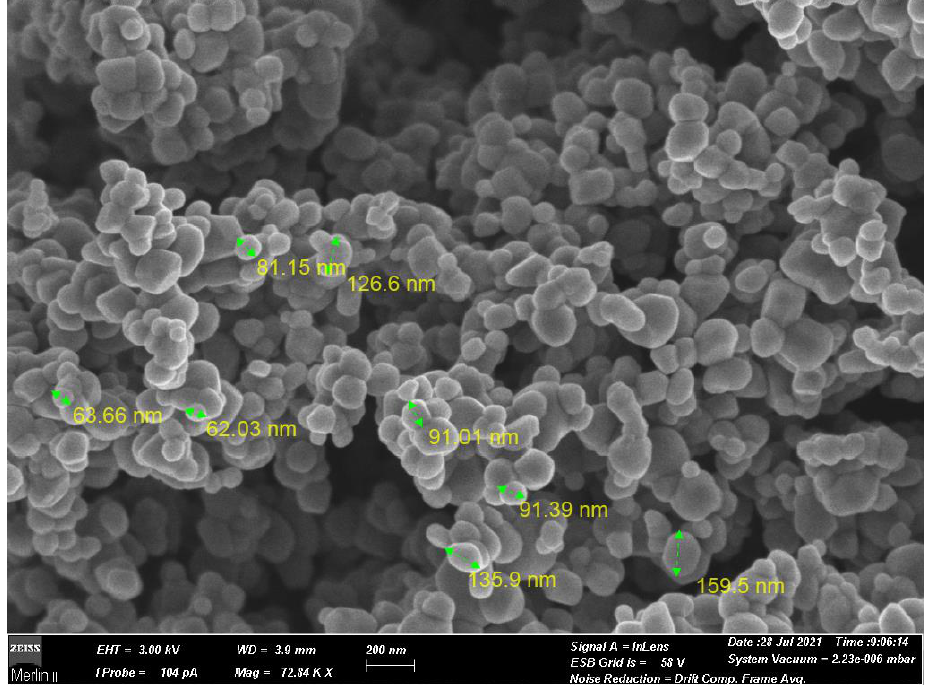
Figure 1. Field Emission Scanning Electron Microscopy-FESEM micrograph of TiO 2 nanoparticles used in this study.